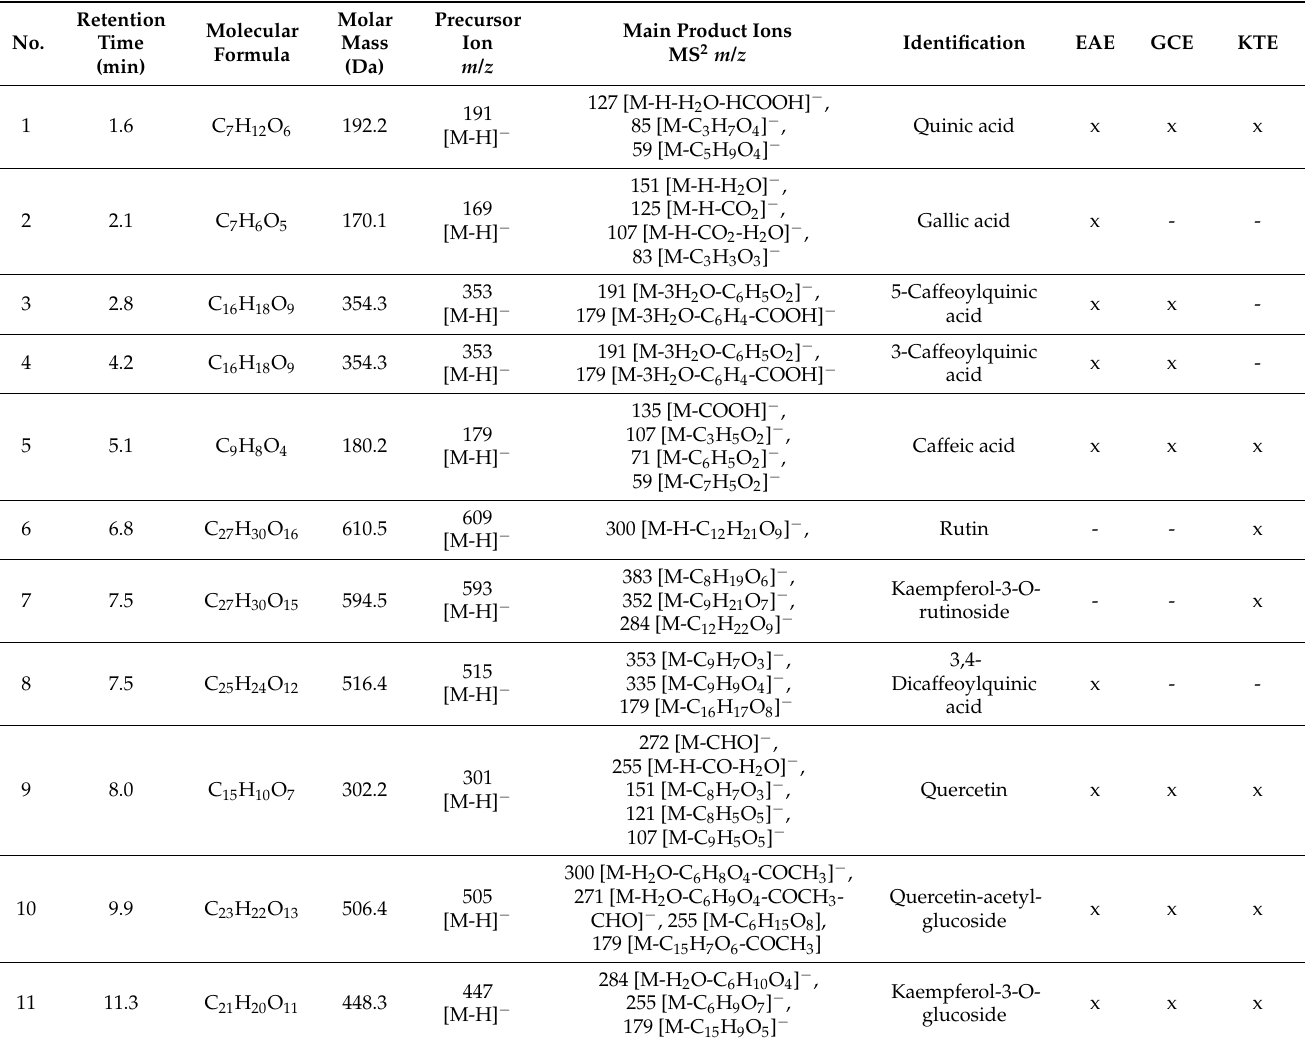
Table 1. Polyphenols detected using HPLC-ESI-MS in Epilobium angustifolium L. (EAE), Centella asiatica L. (GCE) and Clitoria ternatea L. (KTE)